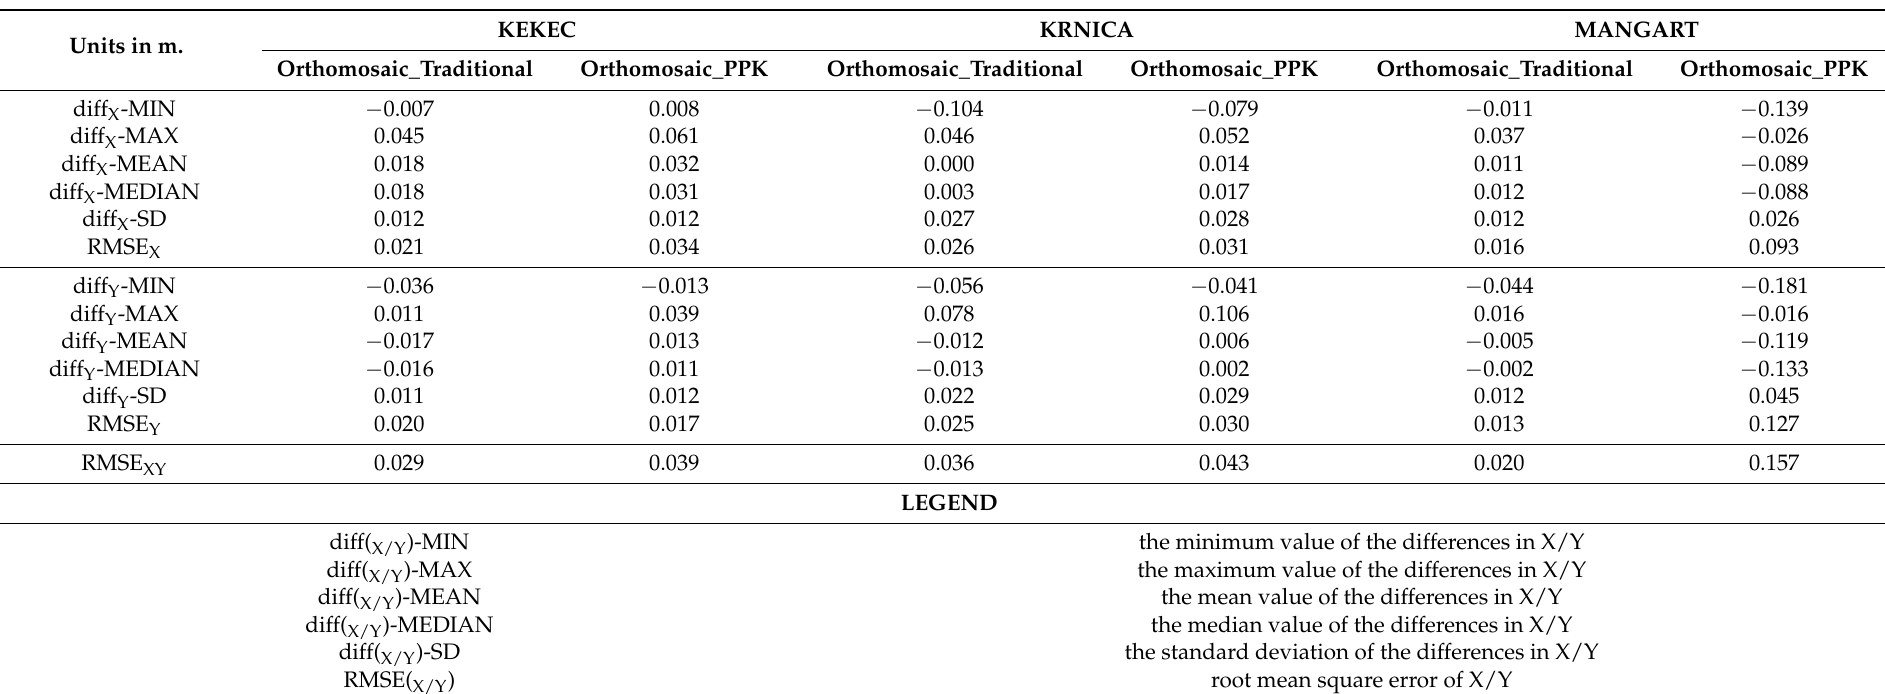
Table 4. Basic statistics for differences in X and Y coordinates measured in the field by the total station and obtained by the orthomosaic_traditional or orthomosaic_PPK methods. Units in